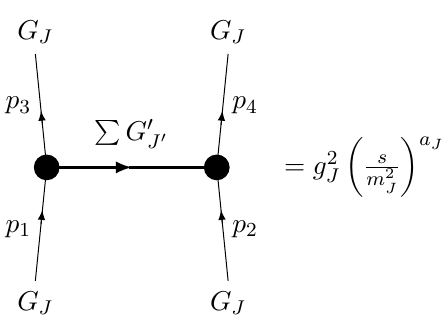
Figure 10 . Phase-shifts associated with non-gravitational interaction between HS particles. This parametrization is defined for specific polarizations of external particles that are given in B. We also set impact parameter b = 1 /m J